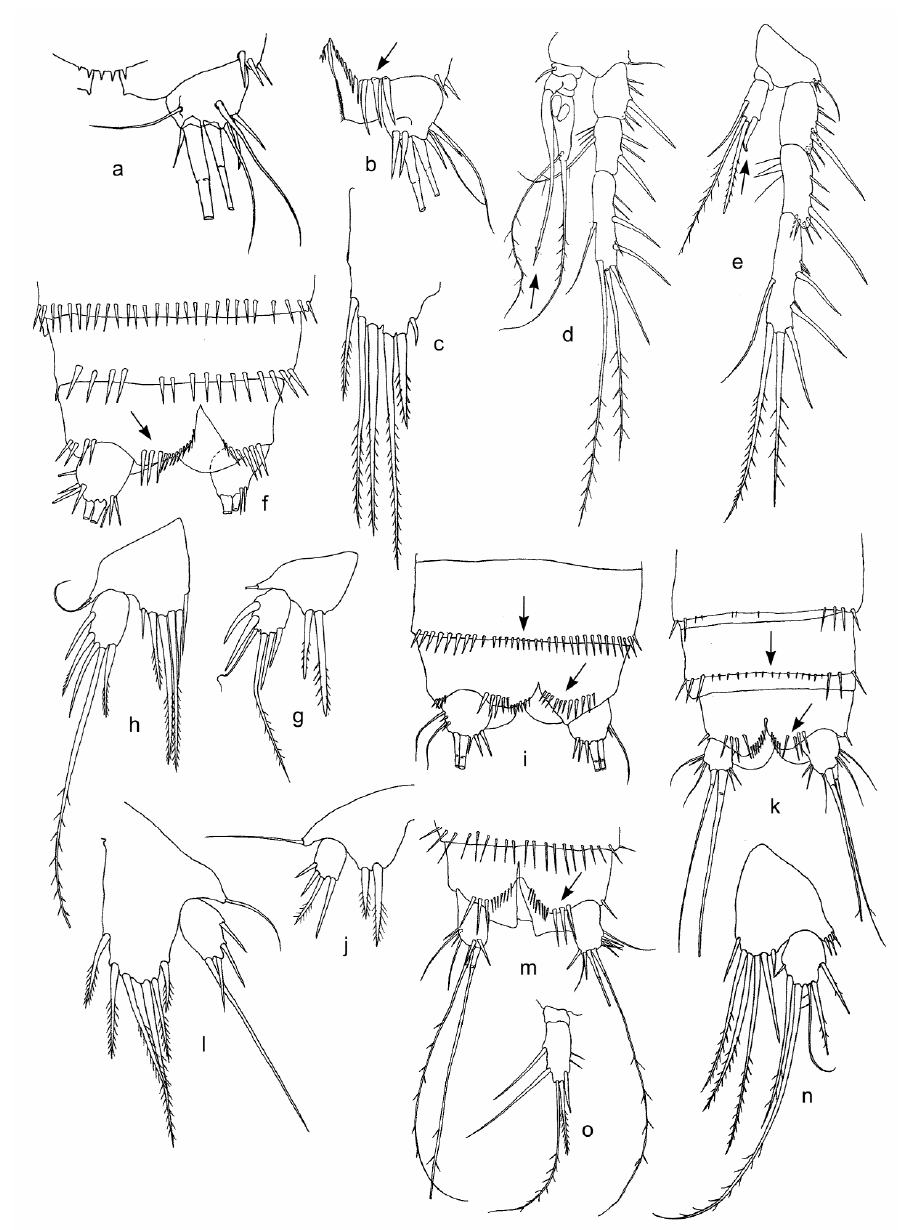
Figure 2. Features of females ( a – c ) and males ( d , e , g ) of Bryocamptus cf. abyssicola ( a – e , g ), female of B. sp. 1 ( f , h ), male of B. smirnovi ( i , j ), females of B. cf. parvus ( k , l ), and B. sp. 4 ( m – o ) from Lake Baikal sites: BGl-d ( a – c ), AdM ( e , g ), Fr ( f , h ), U-M ( i , j ), and VnM ( m – o ). ( a )—caudal rami, dorsal view; ( b )—caudal ramus, dorsal view; ( f , i , k , m )—furca, ventral view; ( c )—baseoendopodal lobe of P5; ( d )—P3; ( e )—P4; ( h , g , j , l , n )—P5; and ( o )—P4 endopod. Abbreviations in Tables 1 and 2. Some features are shown by arrows.